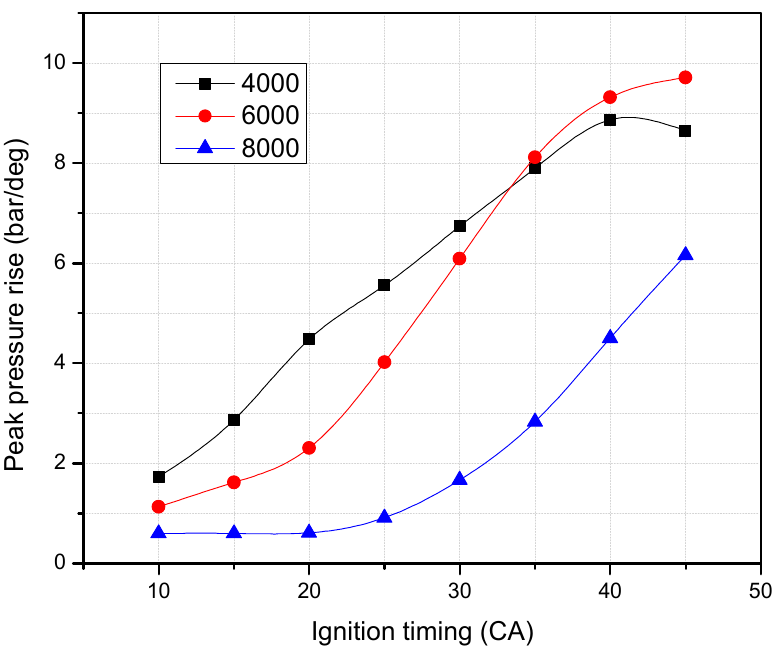
Figure 10. Peak firing pressure versus ignition timing.